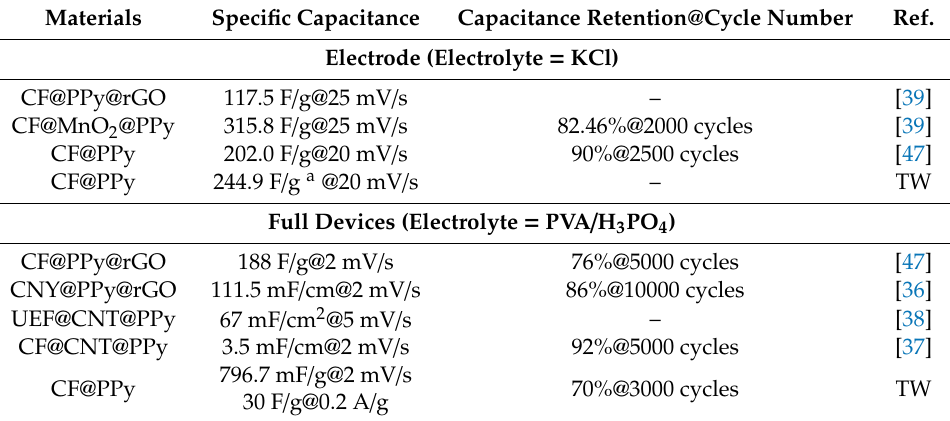
Table 1. Partial list of the material, the electrolyte for testing the performance, and the capacitance as well as the cycling stability for the PPy-based energy storage electrodes and devices. Materials Specific Capacitance Capacitance Retention@Cycle Number Ref. Electrode (Electrolyte =